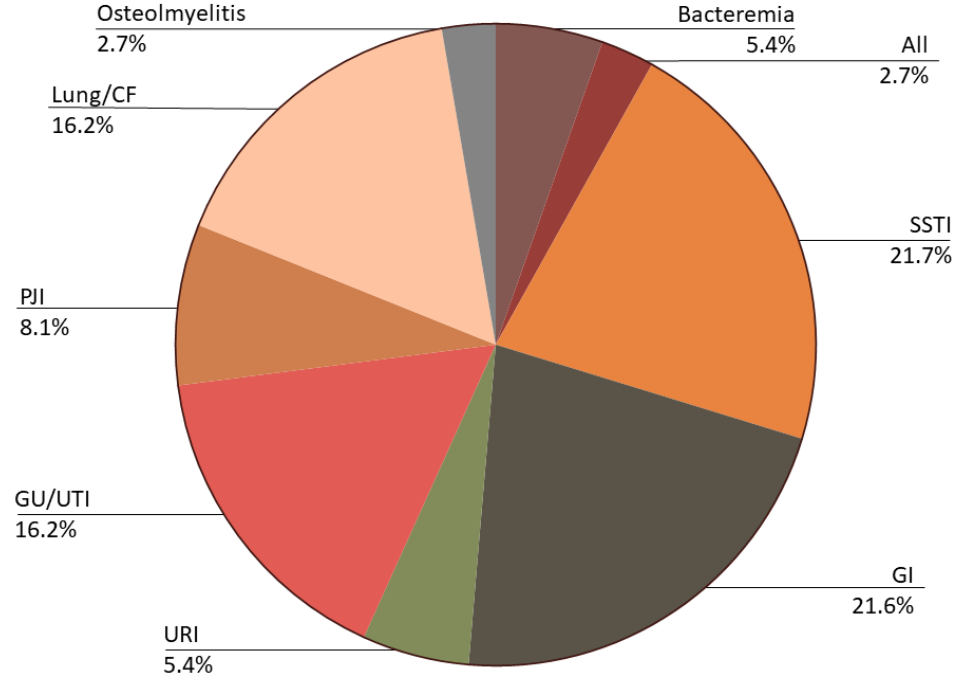
Figure 4. Indications for interventional clinical trials by infection site. A large proportion of currently registered bacteriophage clinical trials on clinicaltrials.gov (43.3%) involve the application of phage for either skin and soft tissue infections (SSTI) or gastrointestinal infections (GI). However, other infection sites, such as genitourinary tract infections (GU/UTI) and lung infections (including those in patients with cystic fibrosis) account for an additional 32.4% of the infections evaluated in these trials. The remaining trials involve patients with bacteremia, osteomyelitis, upper respiratory tract infections (URI), and prosthetic joint infections (PJI). A total of 2.7% of current phage clinical trials evaluate their use in treating non-healing wounds or infections of bones, upper respiratory tract, and genitourinary tract for which extensive antibiotic regimens failed or the use of a targeted drug was contraindicated.